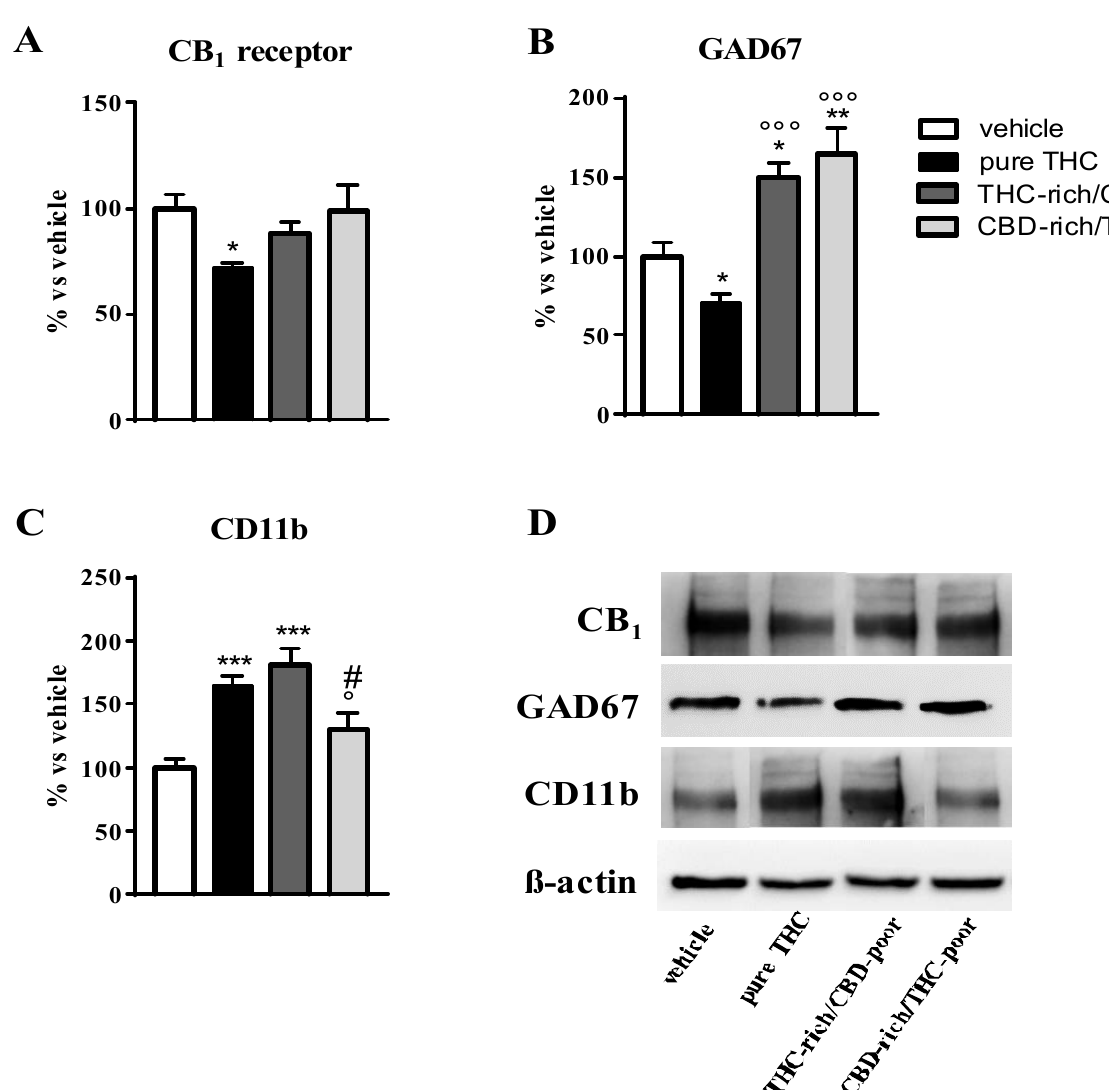
Figure 2. Effect of administration of adolescent THC and THC/CBD combinations on CB1 receptor protein levels (panel A ), GAD67 protein levels (panel B ) and CD11b levels (panel C ) in the adult prefrontal cortex as measured through Western blot analysis. Representative Western blot images are depicted in (panel D ) and refer to one blot out of six. Data are expressed as mean ± SEM of 6 animals per group. *** p < 0.001, ** p < 0.01, * p < 0.05 vs. vehicle; ◦◦◦ p < 0.001, ◦ p < 0.05 vs. pure THC; # p < 0.05 vs. THC-rich/CBD-poor. One-way ANOVA followed by Tukey’s post-hoc test.